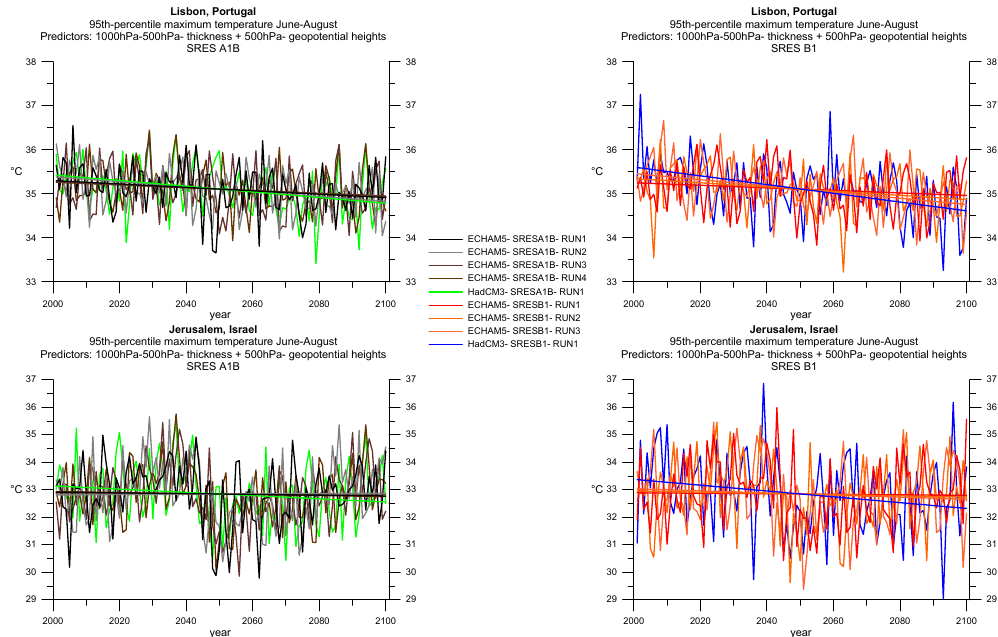
Figure 7: Temporal evolution of PCs for the period 2000 to 2100 in the ECHAM5/MPI-OM model run under SRESA1B assumptions. Left figure: Time series (PC-scores) of the PC2 from the PCA of 1000hPa–500hPa-thickness June–August. The corresponding PC-loadings are illustrated in the upper part of Fig. 6. Right figure: Time series (PC-scores) of the PC9 from the PCA of 500hPa-geopotential heights June–August. The corresponding PC-loadings are shown in the lower part of Fig. 6.